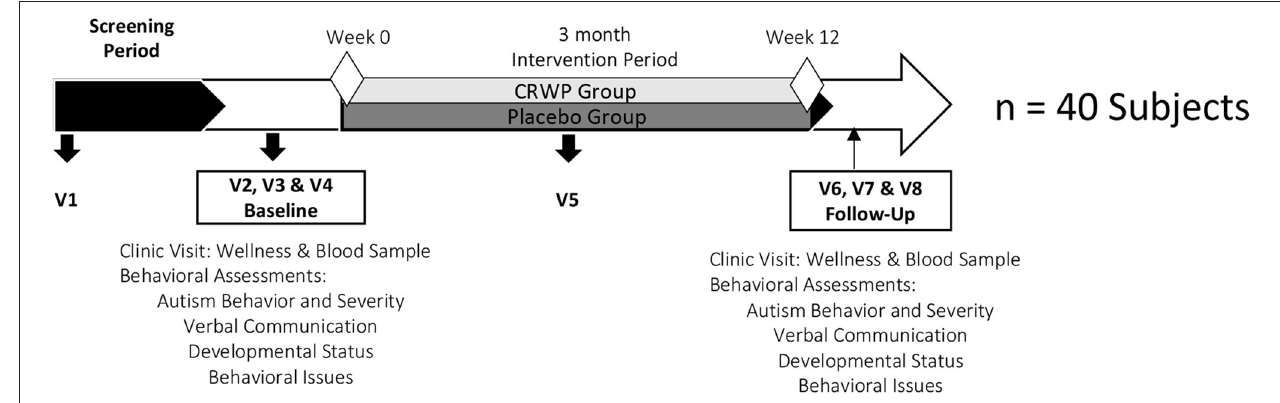
FIGURE 1 | Study timeline. CRWP, cysteine-rich whey protein; V1-V8, Study